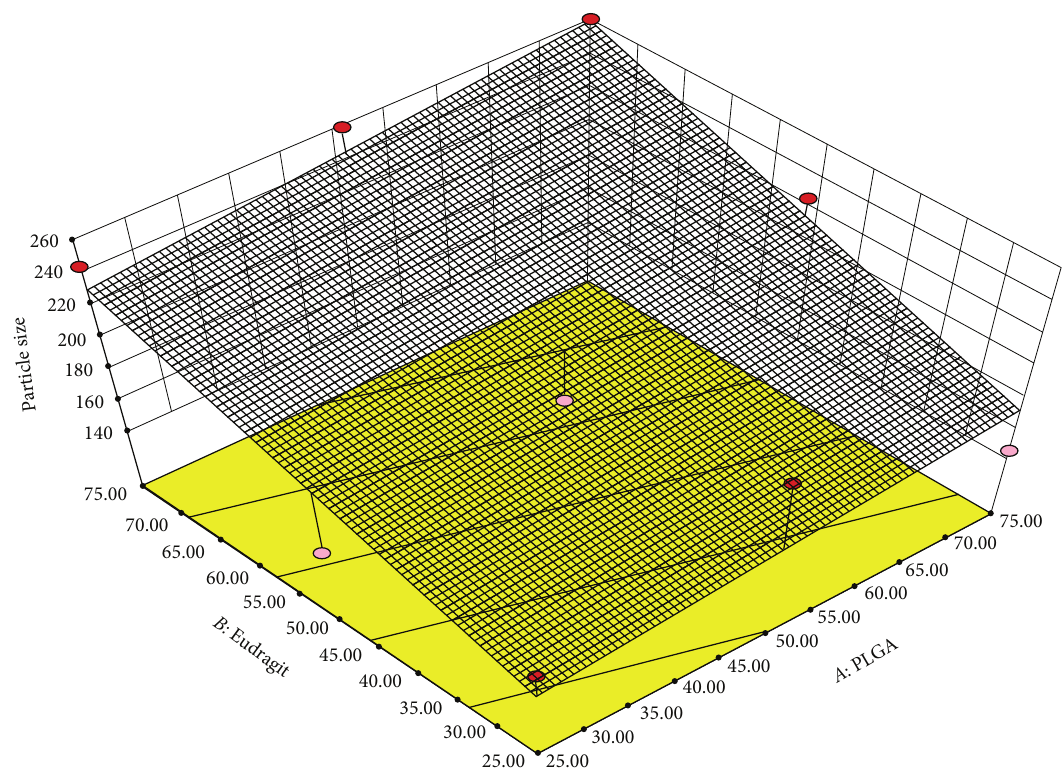
Figure 1: Response surface plots for the A and B on particle size ( 𝑋 1 ), where A = PLGA concentration and B = Eudragit RL100 concentration .